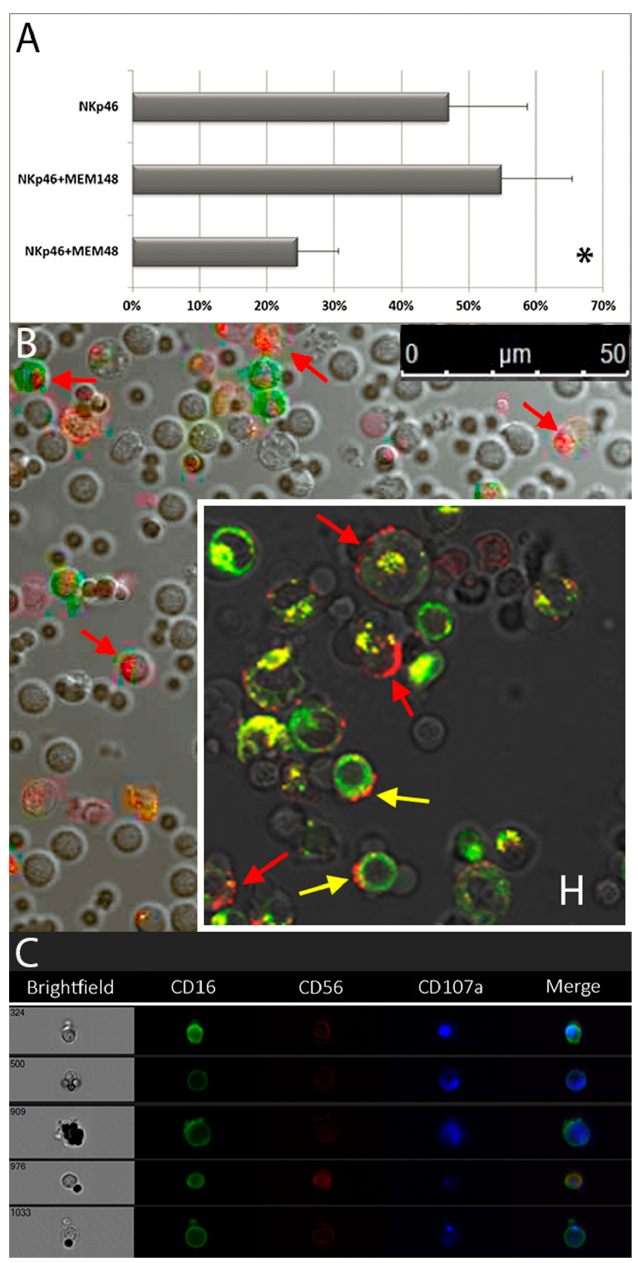
Figure 6. Degranulation and granule polarization analysis of in vitro IL-2-cultured NK cells after stimulation with the indicated mAb combinations. ( A ). Degranulation percentages of IL-2-cultured NK cells stimulated with anti-NKp46 with or without anti-LFA-1 β 2-subunit, clone MEM-48 or MEM-148. Data represent mean +/- SD of at least 5 experiments. * p < 0.05 relative to NK cells stimulated with anti-NKp46 mAb-coated beads. ( B ) Confocal microscopy observation of NK granule polarization of IL-2-cultured NK cells stimulated with anti-NKp46 plus anti-2B4 and anti- LFA-1 β 2-subunit (clone MEM-148) loaded microbeads or (insert H) with green-labelled Jurkat targets. Polarization of CD107a (red spots) expression are indicated by red arrows. Trogocytotic transfer of CD107a (red spots) on some Jurkat green cells (see yellow arrows) and, in some cases, of Jurkat fluorescence (green / orange / yellow spots) on some green negative lymphocytes are also evident. ( C ) ImageStream observations of NK granule polarization of IL-2-cultured NK cells stimulated with anti-NKp46 plus anti-2B4 and anti- LFA-1 β 2-subunit (clone MEM-148). The polarization (spots) of CD107a (blue) is well